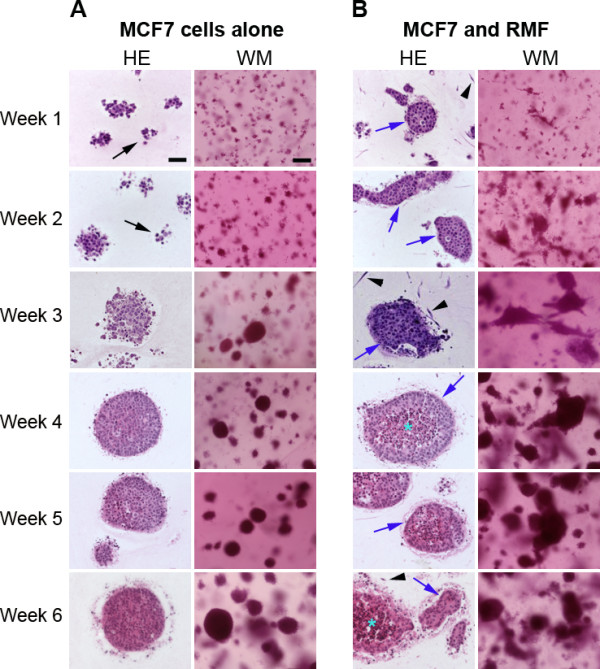
Epithelial structures observed in collagen gels. Panel A depicts representative H&E and whole mounts (WM) of MCF7 cells grown alone in collagen gels for 1-6 weeks. Dead cells are depicted by black arrows. Panel B shows MCF7 cells grown in co-culture with RMF in collagen gels. Note the survival effect provided by the presence of RMF already at week 1. Arrowheads depict fibroblasts, blue arrows depict polarized structures, and * illustrates apoptotic cells. Scale bars: H&E = 50 μm, WM = 100 μm.